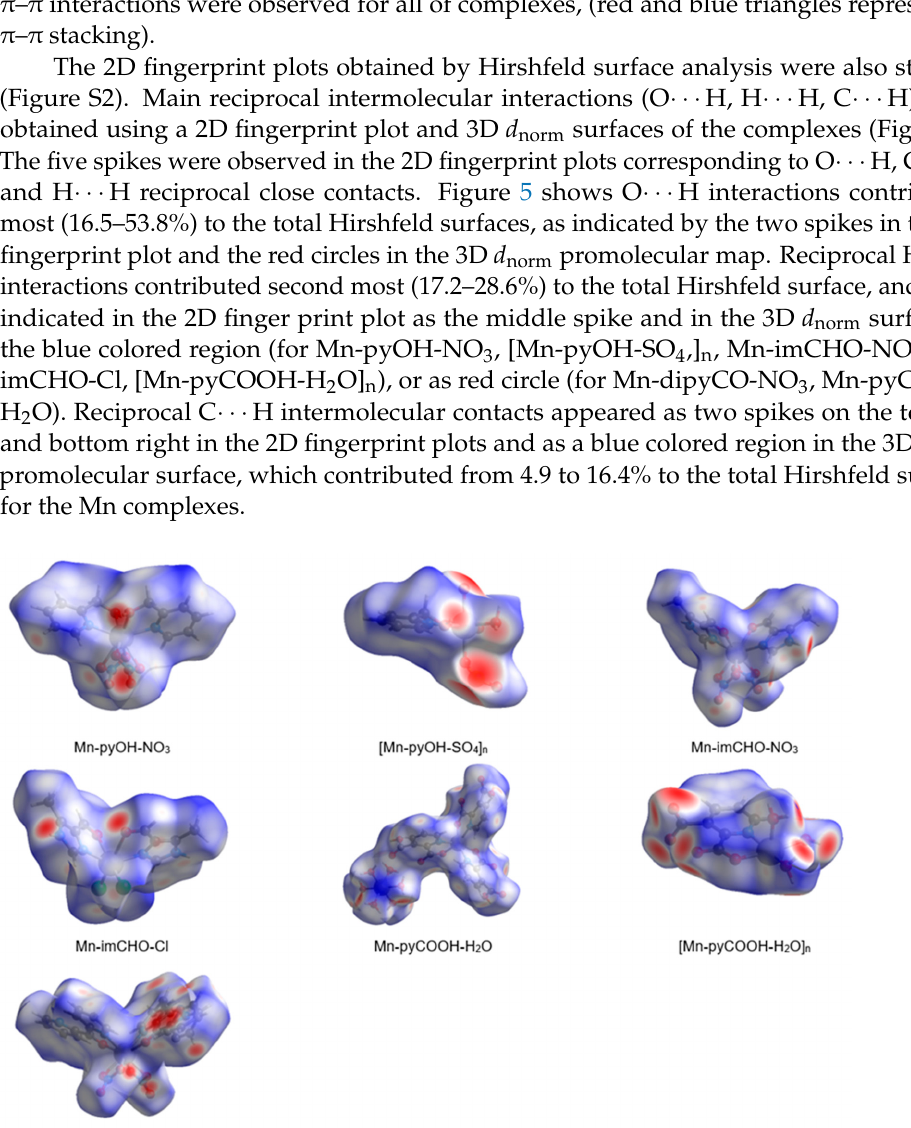
Figure 3. Packing view of the coordination polyhedral system forming a rhombic 3D network and the geometry of C– H ⋯ π (black line) and N–O ⋯ π (green line) interactions (X-H ⋯ π and Y-X ⋯ π interactions, view along [010] direction)—( a ), and π ⋯ π stacking interaction—( b ) for Mn-dipyCO-NO 3 . Cg(1) denotes the gravity ring center of N(31)-C(32)-C(33)-C(34)- C(35)-C(36); Cg(2) denotes the gravity ring center of C(12)-N(11B)-C(16B)-C(15)-C(14B)-C(13B); Cg(3) denotes the gravity